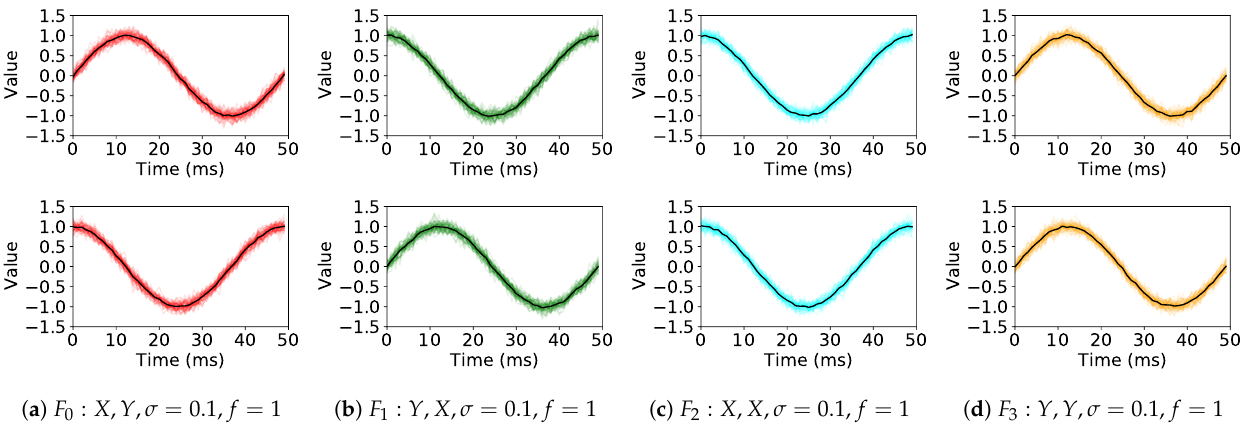
Figure 1. Synthetic dataset with four time-series families in two dimensions. Black curves report the centroids according to the K-Multi-Dimensional Time-Series Clustering